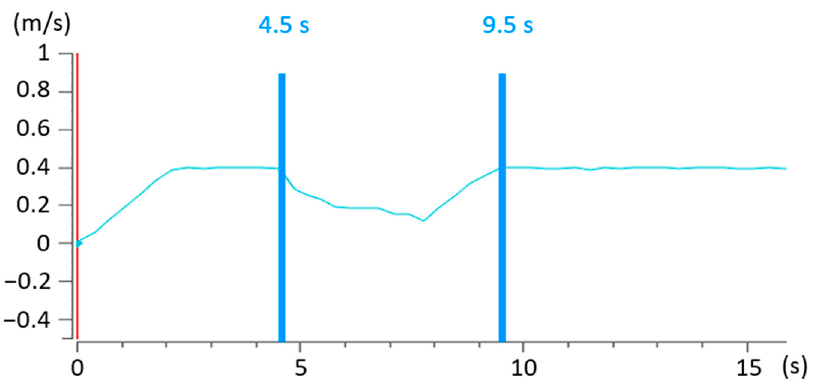
Figure 11. ( a ) The robot passes by a customer and ( b ) the robot moves away.